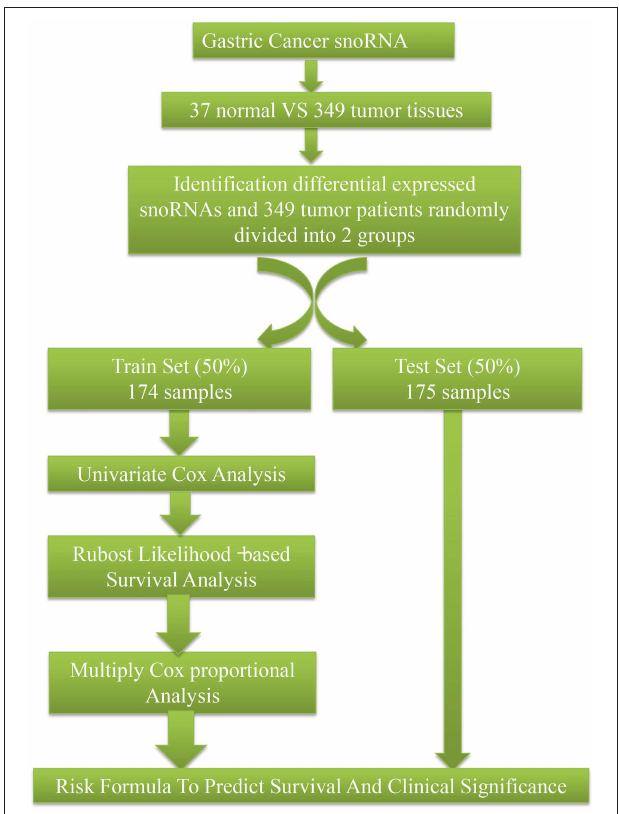
FIGURE 1 | The main workflow of this study.